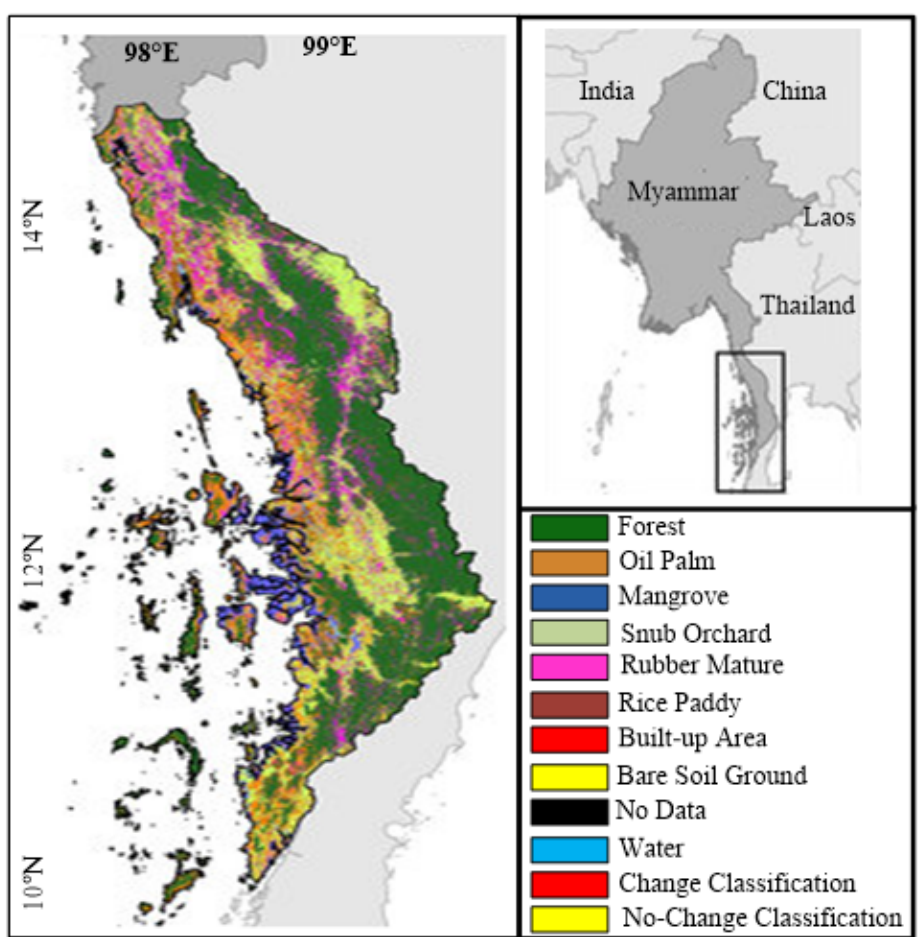
Figure 4. Image classification for the Tanintharyi region location in southern Myanmar.